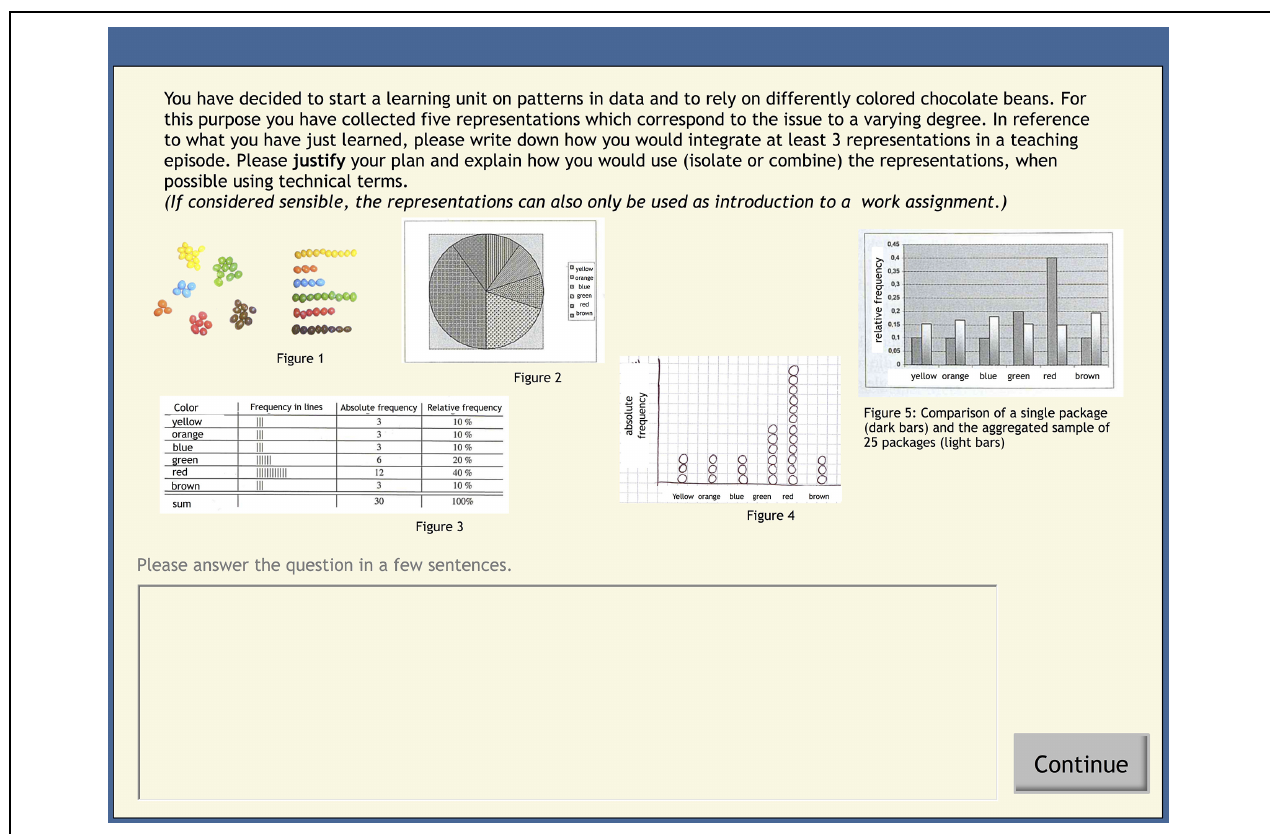
FIGURE 3 | Screenshot of a mathematics-classroom scenario from the post-test (translated from German). The student teachers completed this task individually. Different elements should be combined in accordance with the principles taught in the preceding learning environment(s).